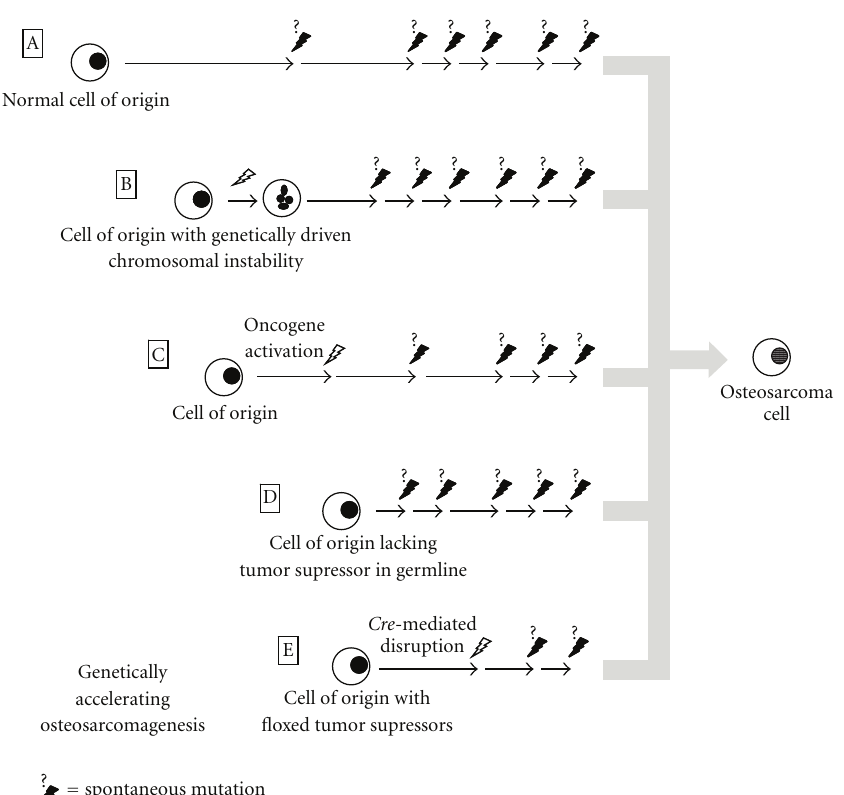
Figure 2: Genetically wild-type cells can naturally accrue su ffi cient mutations to initiate osteosarcomagenesis in mice as evidenced by the background incidence of osteosarcomas a little under 5 percent in most strains (A). Genetically induced aneuploidy alone, in most of its forms, is ine ffi cient in osteosarcomagenesis (B). Expression of oncogenes as transgenes using native promoters, introduced via insertional viral vectors or unmasked by radiation, can lead to benign and malignant bone neoplasia in mice (C). Inherited germline deletion of tumor suppressors in heterozygosity or homozygosity or generation of mouse chimeras of cells with and without such deletions to avoid serious developmental defects have proven the e ffi ciency of many gene inactivations in osteosarcomagenesis (D). Another means by which severe developmental phenotypes may be eschewed or potential cells of origin tested is by the use of conditional oncogene activation or conditional tumor suppressor ablation, specified either temporally or, by tissue, spatially (E); combinations of tumor suppressor deletions, possible in conditional ablation methods, have been very e ffi cient at driving